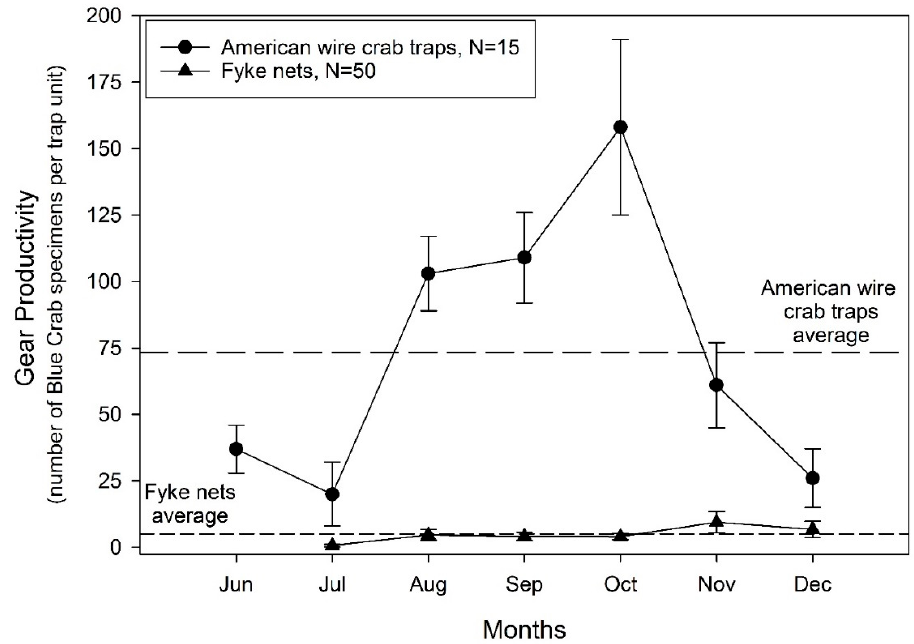
Figure 4. Comparison of the average monthly capture rate (number of specimens per trap) of Blue Crab Callinectes sapidus in the wire crab traps and traditional fyke nets from the Parila lagoon (Eastern Adriatic, Croatia) during the period June–December 2019. The black circles are average monthly numbers of Blue Crab per wire trap ( n = 15) and the black triangles are average monthly numbers of Blue Crab per fyke net ( n = 50). The vertical bars represent standard deviations.